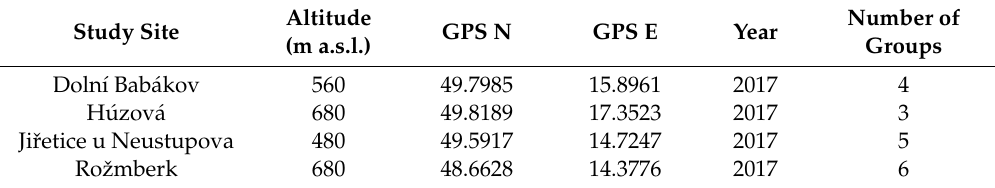
Table 3. Study sites for experiment 5. Each group included three kinds of traps. Study